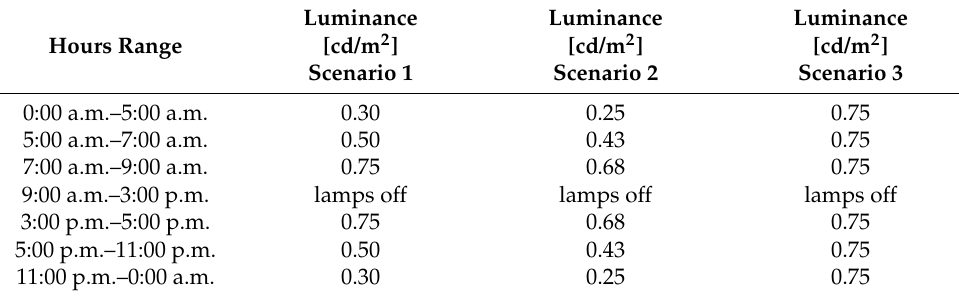
Table 6. Luminance values for given lighting scenarios.